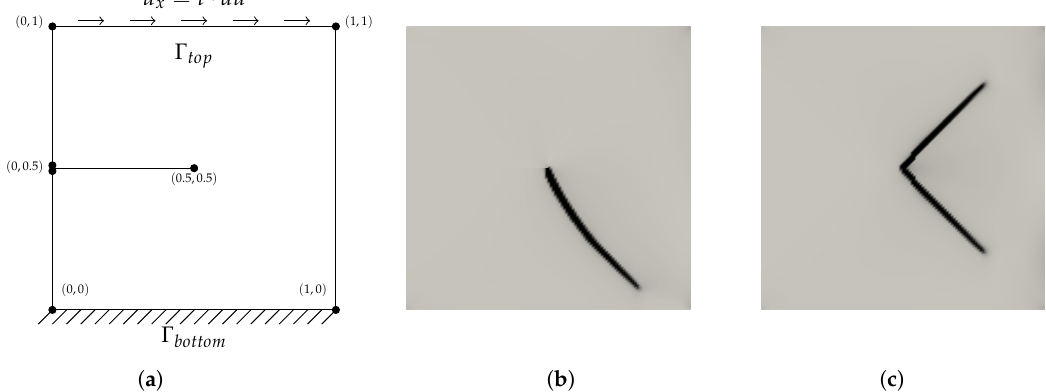
Figure 5. ( a ) Geometry for the single-edge notched shear tests (values given in mm). ( b ) If we apply Miehe-splitting, the fracture moves along a curved path towards the bottom of the body. ( c ) In the isotropic case (no splitting), two symmetric crack branches emerge.